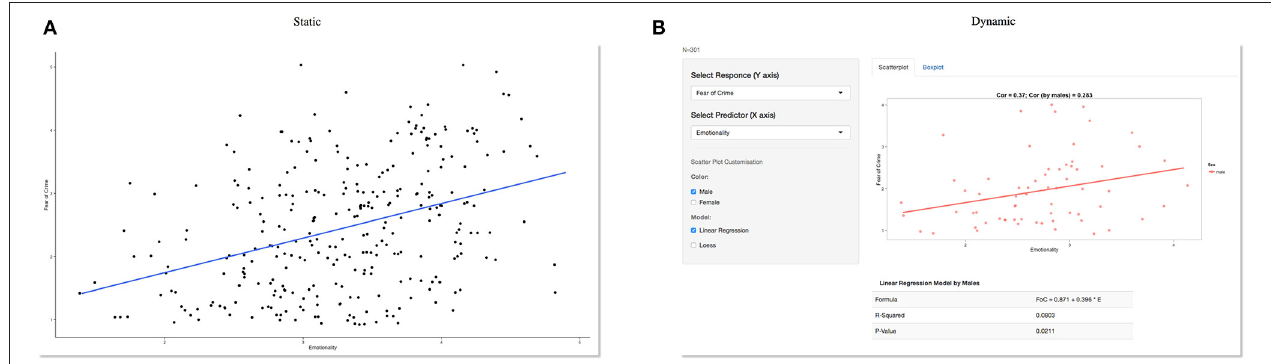
FIGURE 1 | Static vs. dynamic data visualization. A static graph showing a positive relationship between fear and emotionality (A) can quickly be turned into a dynamic visualization (B) which in this example allows a website visitor to select a sub-group (male participants) of interest. Other variables are also available from the drop-down menus on the left and the included statistical analysis updates automatically based on user selections. However, this relies on the data being available to both a user interface and server to process these requests. Previously this was only possible by developing interactive web applications using a combination of HTML, CSS, or Java. However, this is no longer a limiting factor. For those who have a basic knowledge of R , the move from static to dynamic reporting is relatively